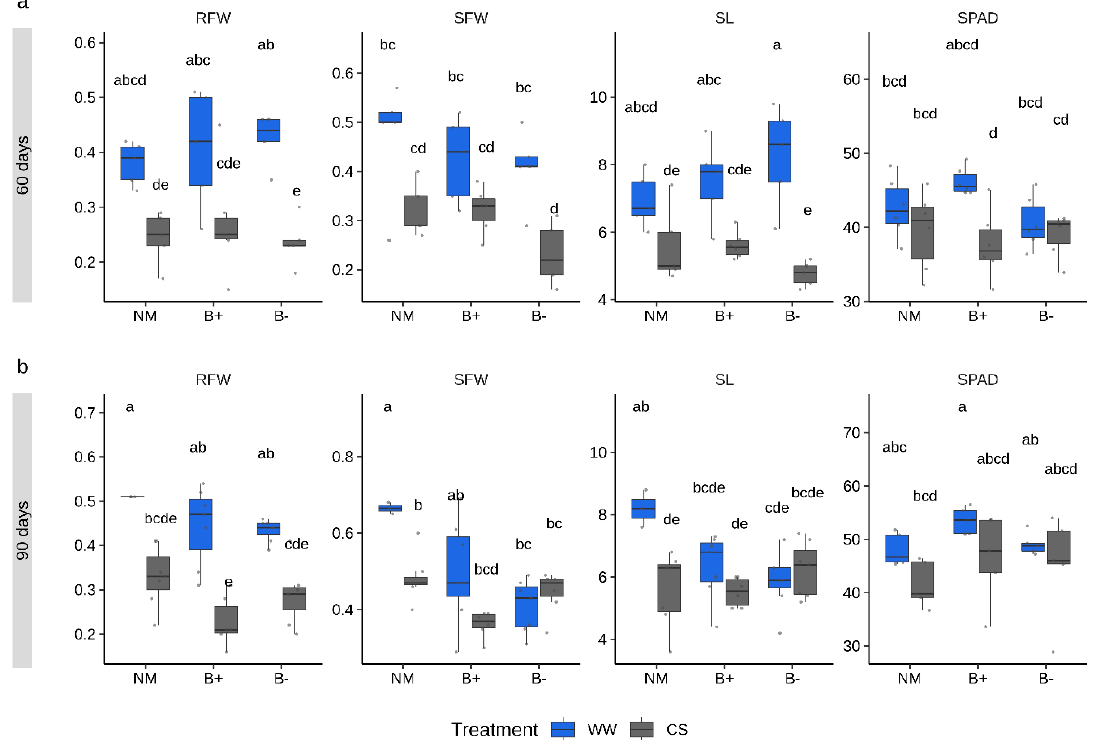
Figure 2. Plant traits measured in tomato inoculated with G. margarita containing or not its endobacteria (B+ and B-, respectively) under combined stress (CS, gray) or well-watered (WW, blue) conditions sampled after 60 ( a ) and 90 ( b ) days. Differences between conditions, stress treatment and time points are indicated for each parameter with different letters according to Tukey’s HSD (honestly significant difference) post hoc test after ANOVA ( P < 0.05). CS, combined stress, WW, normal control conditions. RFW, root fresh weight (g), SFW, shoot fresh weight (g), SL, shoot length (cm), SPAD index. Boxplots display median value (horizontal line), quartiles (boxes) and 1.5 × interquartile ranges (whiskers).